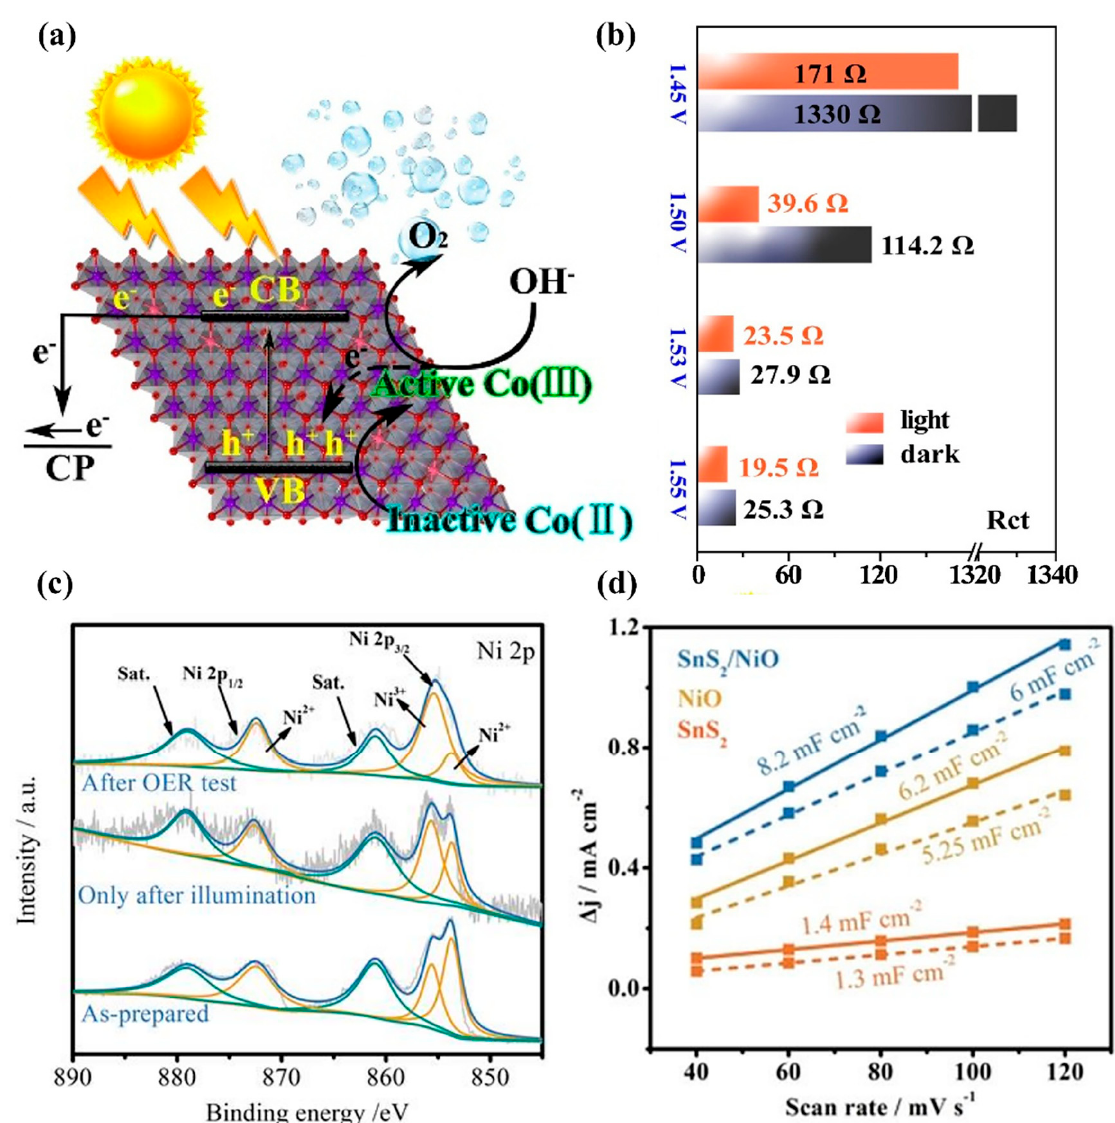
Figure 6. ( a ) Schematic diagram of the photogenerated hole-assisted OER mechanism for CoCr- LDH and ( b ) comparison of charge transfer resistance under different applied biases. Adapted with permission from ref. [30]. Copyright 2021, Elsevier. ( c ) Ni 2p XPS spectra of SnS 2 /NiO and ( d ) C dl values of SnS 2 /NiO under dark and light conditions. Adapted with permission from ref. [45]. Copyright 2021, Wiley—VCH. Table 2. The main catalysts, experimental conditions, and activities of photogenerated carrier- assisted electrocatalysts for OER.